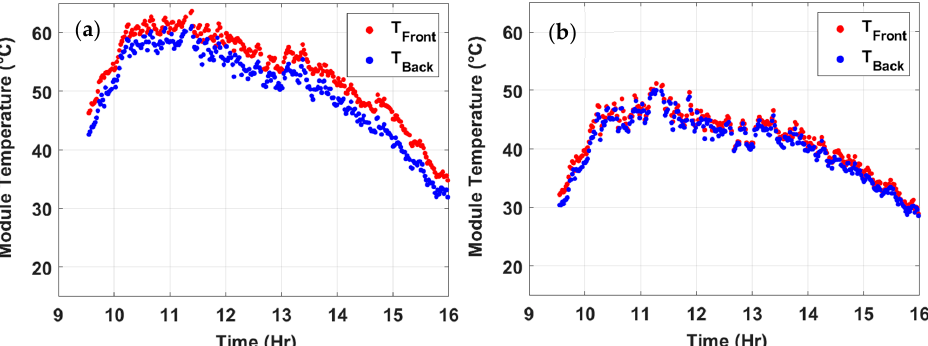
Figure 2. Example of measured temperatures of the minimodule on the front and back surfaces as a function of time for bifacial ( a ) and monofacial ( b ) minimodule measured in one of the days of measurement.